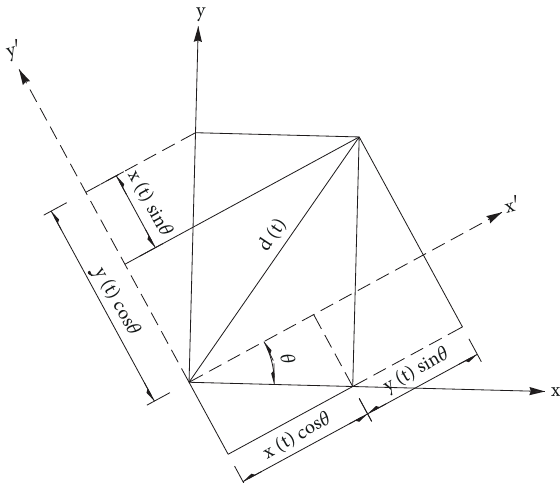
Figure 8: Coordinate transformation diagram.